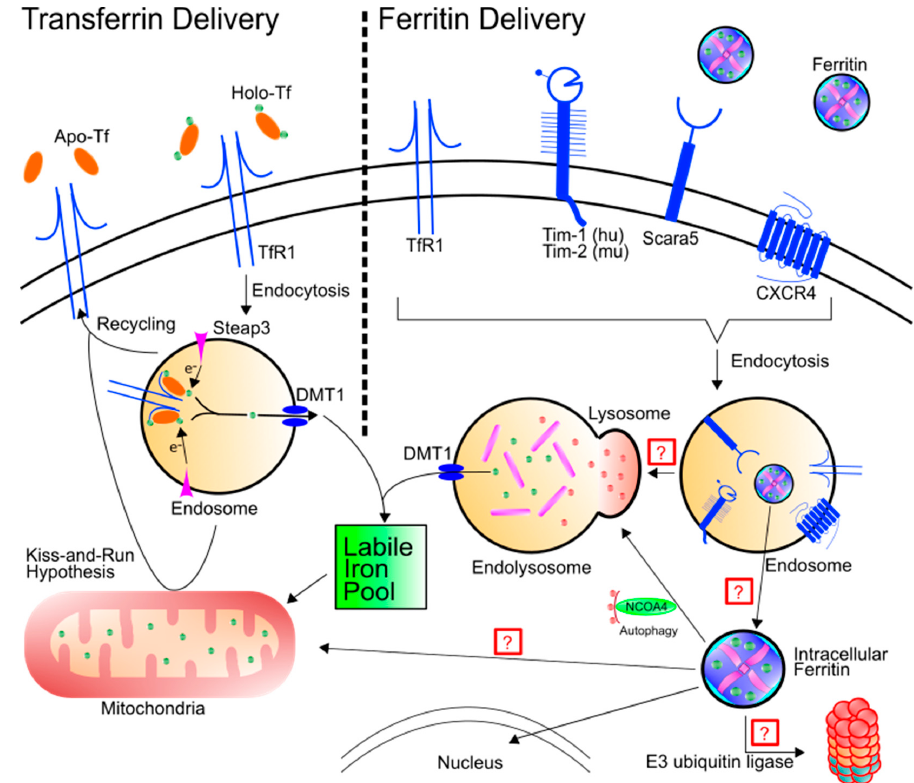
Figure 1. Schematic of transferrin and ferritin uptake and intracellular destiny. Left: Holo-Tf can bind to TfR1 and deliver iron into the labile iron pool through the endosome via DMT1. TfR1 can also be recycled to the cell surface, depositing apo-Tf into the extracellular matrix. An alternative hypothesis termed “kiss-and-run” results in endosomal delivery of iron to the mitochondria by brief interactions between the endosome and the mitochondria. Right: Ferritin binding has been shown for TfR1, Tim-1, Tim-2, Scara5, and CXCR4. After binding, ferritin is endocytosed. Note, while not all receptors are simultaneously required for endocytosis of ferritin, the schematic is demonstrating that all of the receptors in question have been found in the endosome. Ferritin trafficking after endocytosis has yet to be fully elucidated. Hypotheses include trafficking to the lysosome for protein degradation or for ferritin to leave the endosome through another means. Once ferritin is cytosolic, it can be shuttled to the lysosome via NCOA4 or it may be transported to the nucleus. There are a number of other potential hypotheses as well: (1) Ferritin may be poly-ubiquitinated and degraded by the proteasome or (2) ferritin may be shuttled to the mitochondria to deliver iron.